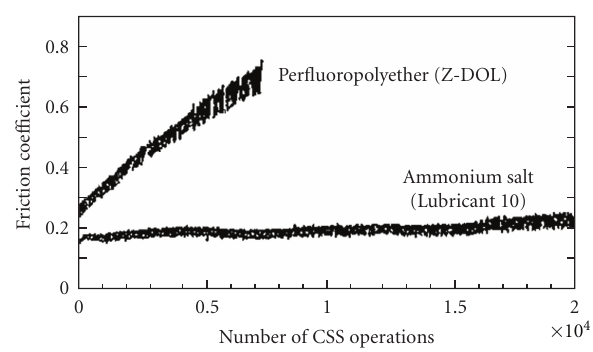
Figure 5: Frictional coe ffi cient of disk coated with lubricant (10) versus number of CSS operations. The functional PFPE (Z-DOL) shown for